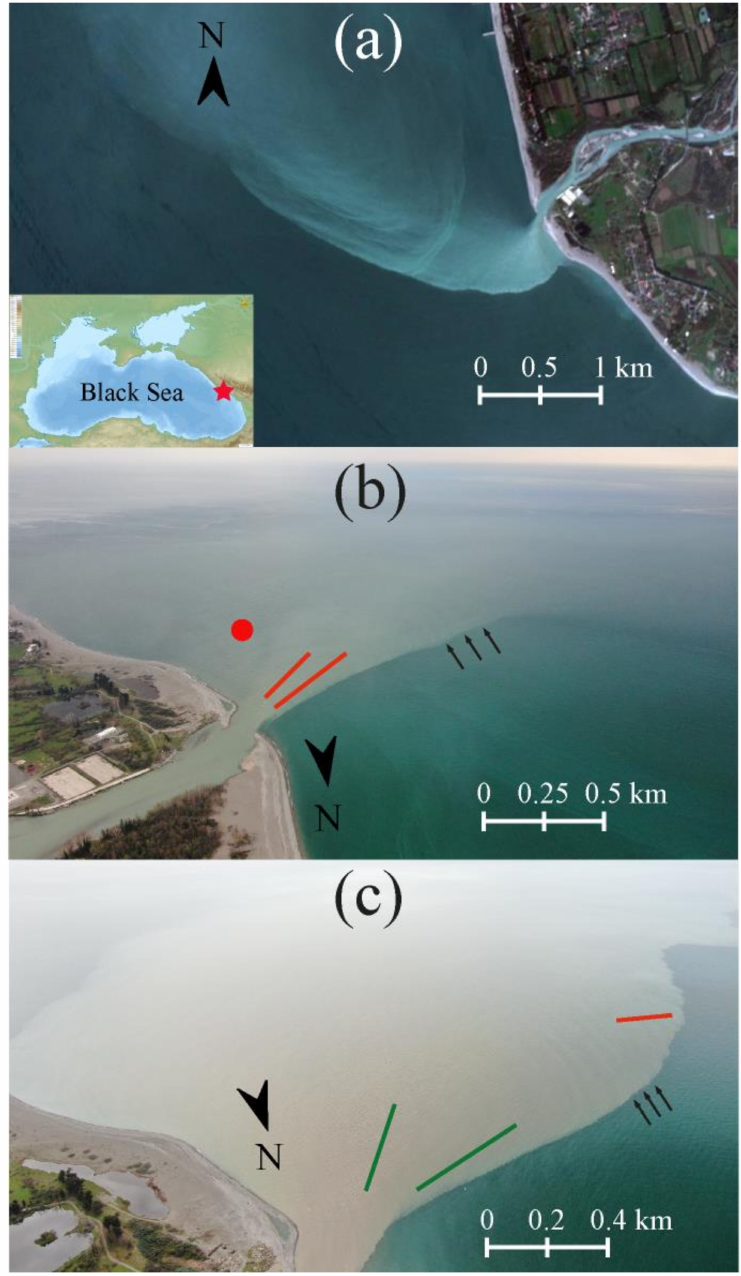
Figure 1. Study area: ( a ) satellite image (Sentinel-2) of the Bzyb plume acquired on 15 April 2021; ( b , c ) aerial images of the Bzyb plume acquired during the field survey on ( b ) 16 April 2021 at 15:30 and ( c ) 18 April 2021 at 11:45. The red star at the inset in the panel ( a ) indicates location of the Bzyb plume in the eastern part of the Black Sea. The black arrows in panels ( b , c ) indicate ring-like features within the Bzyb plume. The red lines in panels ( b , c ) indicate trajectories of free-drifting boat on 16 and 18 April. The green lines in panel ( c ) indicate trajectories of free-drifting buoy on 18 April. The red circle in panel ( b ) indicates the location of the mooring station on 16